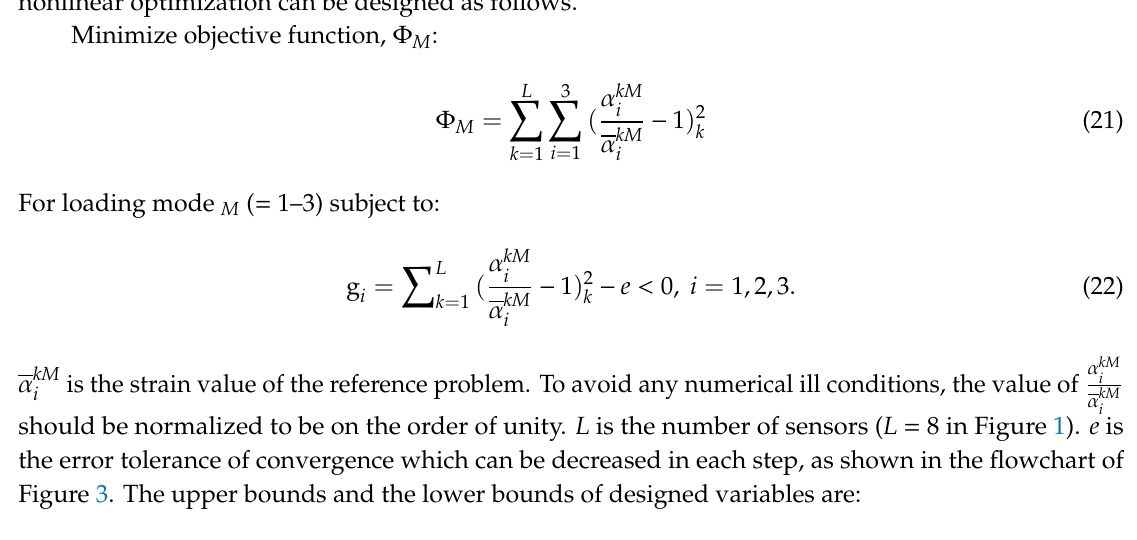
Figure 2. Loading modes of a crack in the square composite plate.